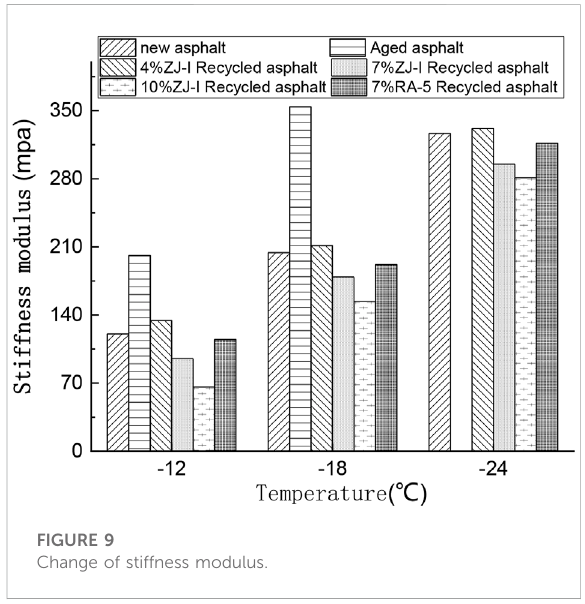
FIGURE 9 Change of stiffness modulus.